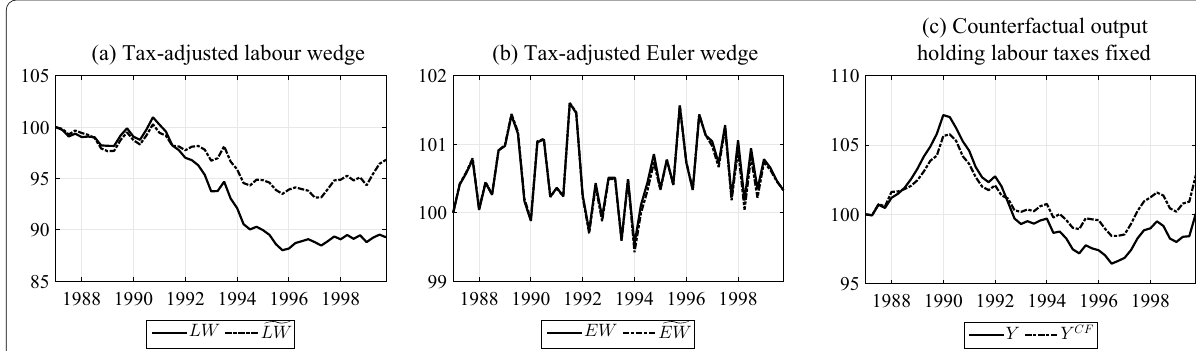
LW denote the labour and tax-adjusted labour wedges, respectively. EW and (cid:31)